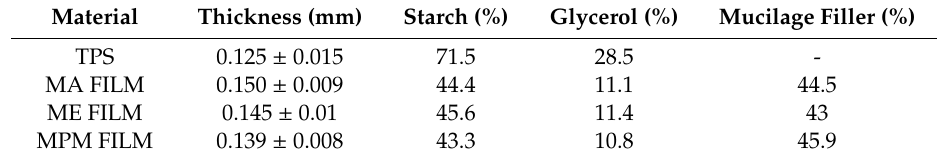
Figure 5. Optical micrographs of dry Opuntia mucilage at different magnifications . Table 1. Thickness and composition of thermoplastic starch (TPS) and TPS–nopal mucilage films.